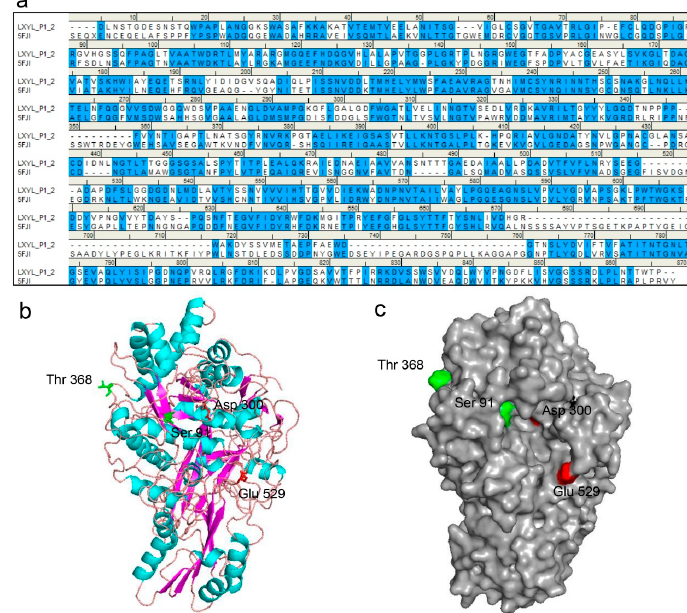
Figure 4. The LXYL-P1–2 structure predicted by homology modeling. ( a ) Sequence alignment between LXYL-P1–2 and the template GH3 β -glucosidase from A. fumigatus (PDB 5fji). Identical and similar residues are highlighted in blue; ( b ) Three-dimensional structure view. The β -strands are represented as magenta, α -helices as cyan, and loops are colored in salmon; ( c ) Surface view. The catalytic sites (Asp 300 , Glu 529 ) are indicated in red, the substitutions occurred in the mutants EP1 and EP2 are indicated in green. The homology model of LXYL-P1–2 was constructed based on the template GH3 β -glucosidase from A. fumigatus (PDB 5fji) using